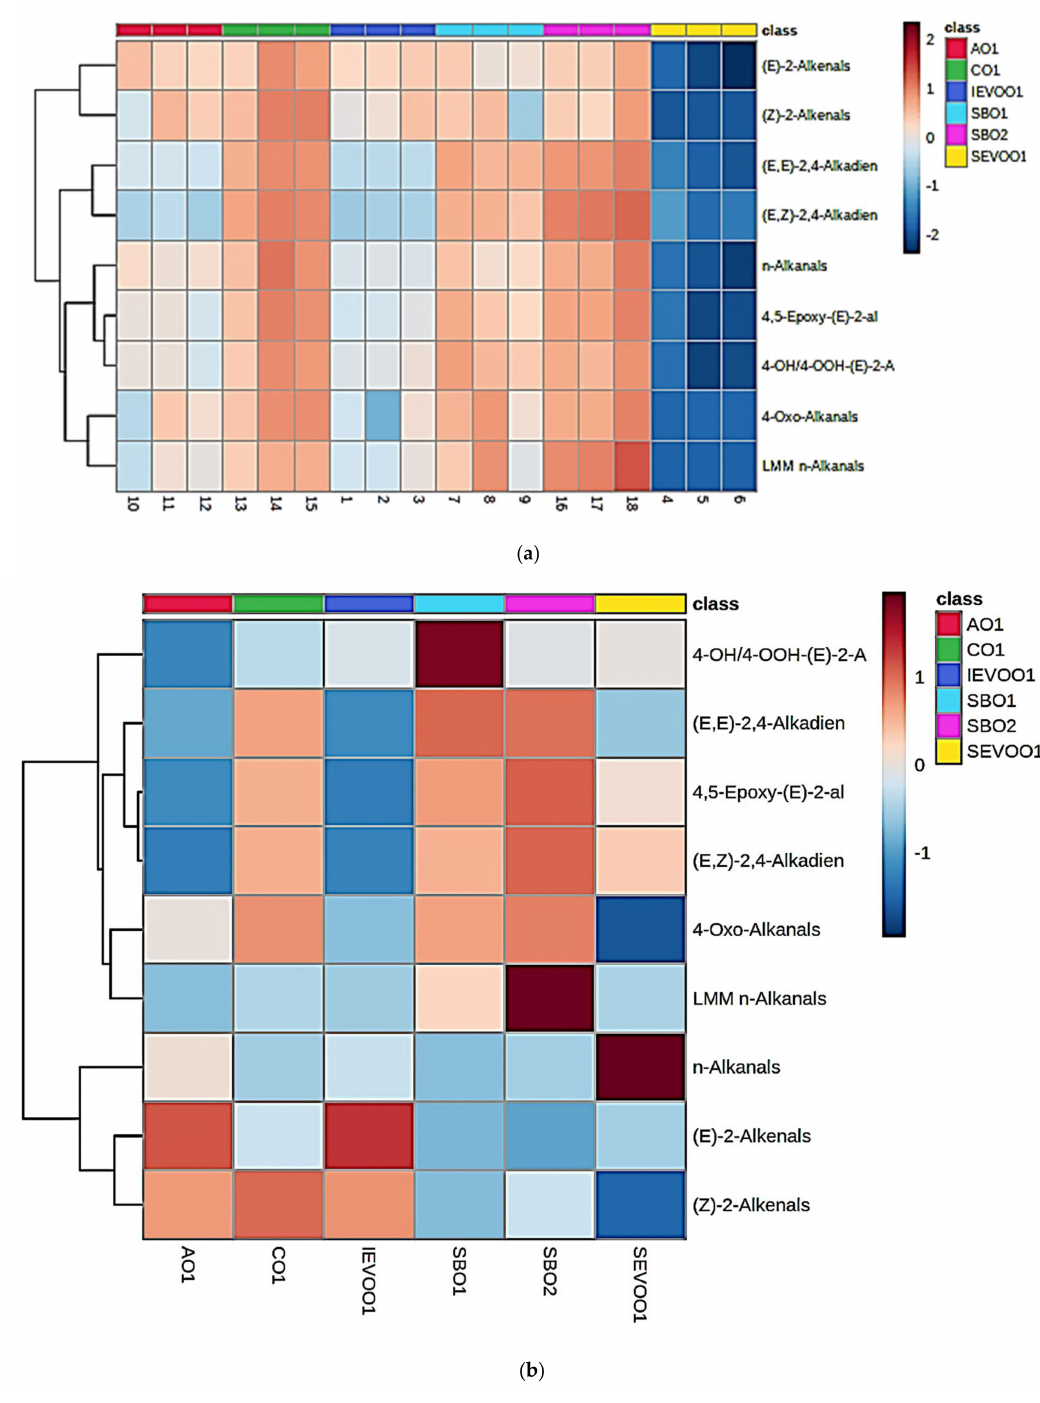
Figure 3. ( a ) Heatmap diagram displaying the nature, extent and ANOVA-based significance of univariate differences between all nine aldehydic LOP variables (near right-hand side ordinate axis) for the avocado (red), corn (green), Italian extra-virgin olive (dark blue), soybean 1 (cyan), soybean 2 (mauve) and Spanish extra-virgin olive 1 (yellow) oil products at the 90 min LSSFE time-point only. The complete dataset was glog-transformed and autoscaled prior to analysis, but not constant sum-normalized (CSN). Transformed analyte intensities are shown in the far right-hand side ordinate axis: deep blue and red colorations represent extremes of low and high concentrations, respectively. The left-hand side ordinate axis of this plot shows results derived from an associated agglomerative hierarchical clustering (AHC) analysis of these aldehyde variables. ( b ) Corresponding heatmap diagram of only the 90 min heating time-point dataset, but following the application of CSN prior to analysis. Oil type abbreviations: as Section